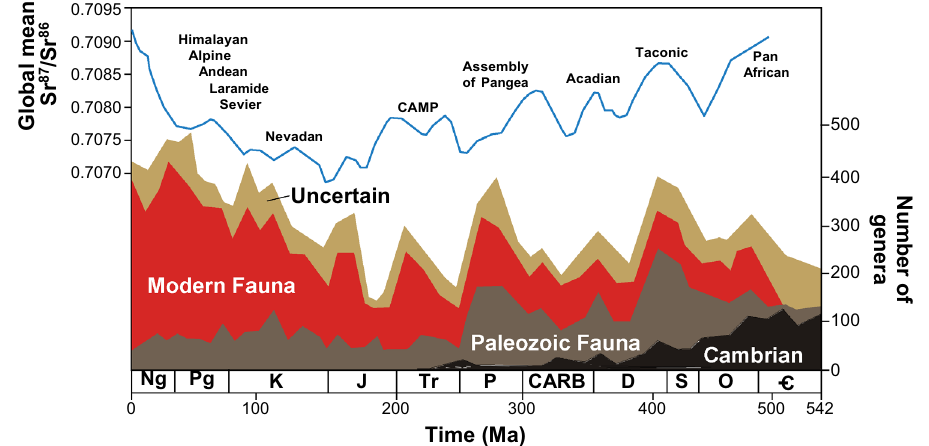
Figure 1. Marine biodiversity and major orogenic and tectonic phases during the Phanerozoic Eon. Genus- level richness (redrawn from 3 , based on 2) with strontium isotope ( 87 Sr/ 86 Sr) curve (at 1 myr intervals 5 ). Major orogenic episodes for the Phanerozoic are indicated. CAMP = Central Atlantic Magmatic Province is associated with the breakup of